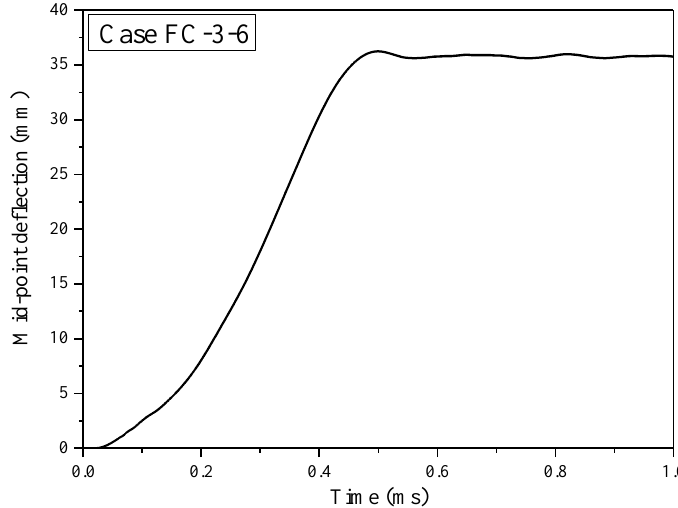
Figure 6. Typical midpoint deflection–time history of the target top plate (Case FC-3-6).